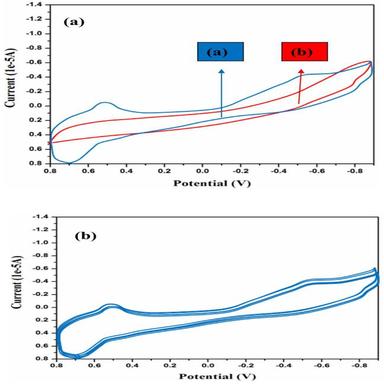
CV analysis.(a) and (b) CdO-SnO2 nanocomposite material GCE in 0.1 M KCl segment 5).